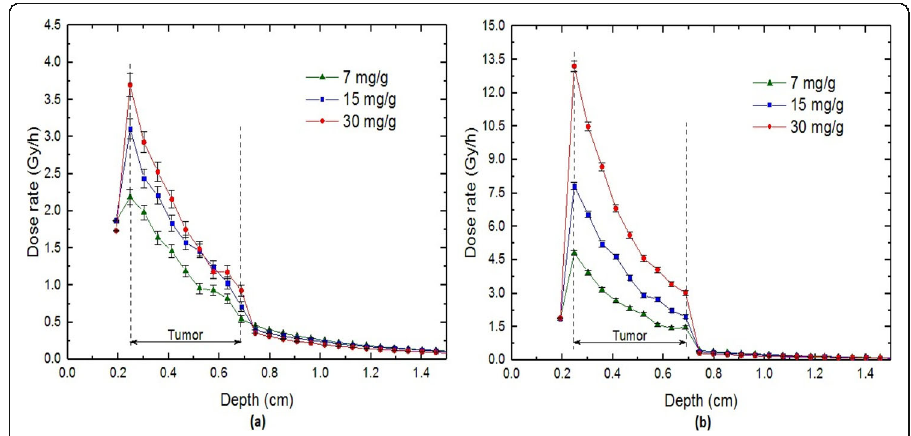
Fig. 5 The dose rates calculated in the depth of the eye phantom containing a tumor filled with 100 nm GNPs with concentrations of 7, 15, 30 mg/g for a the homogeneous model. b The heterogeneous